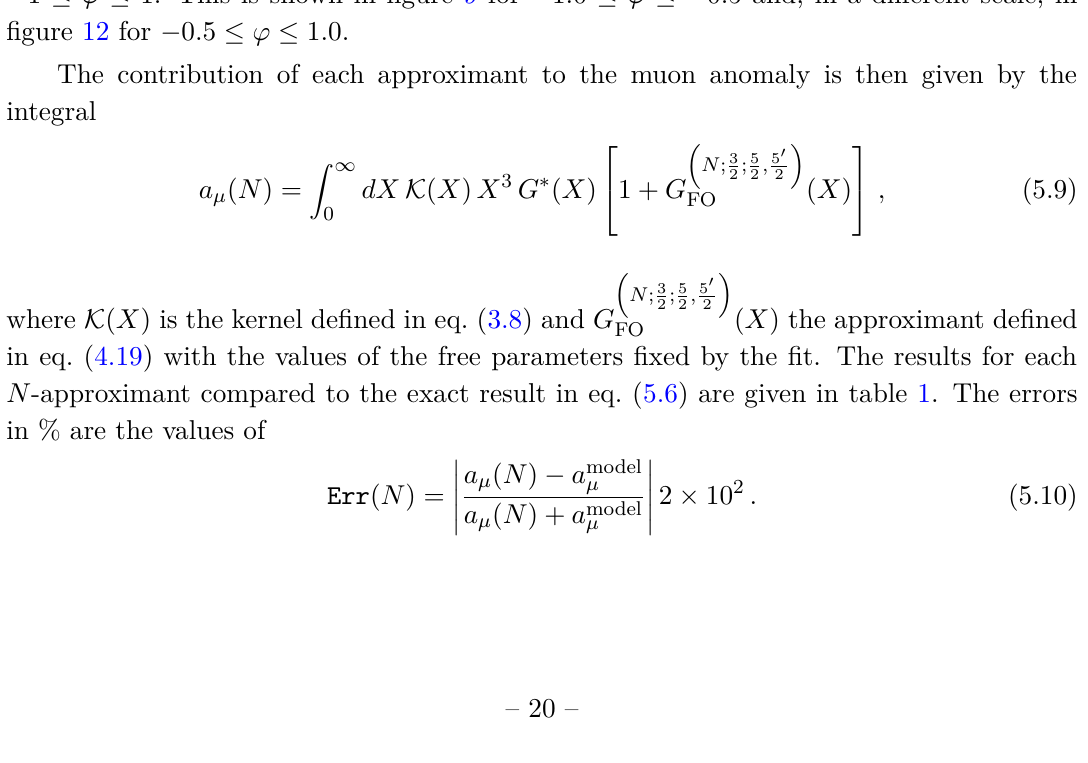
(cid:0) (cid:1) N ; 3 ; 5 , 5 0 ( x ) in eq. (4.19) for N = 3 (green), N = 7 2 2 2 0 FO ( x ) which the approximants are expected to 0 FO